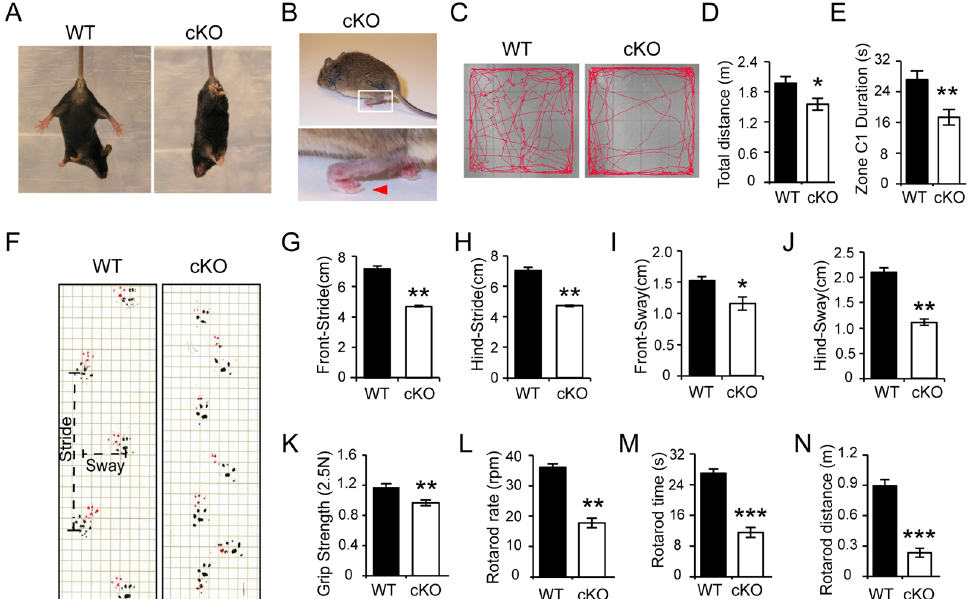
Figure 1. Thorase cKO mice exhibit behavioral deficits. ( A ) Thorase cKO mice show tremor and limb-clasping reflexes in the tail suspension test. ( B ) Thorase cKO mice at the age of 6 months walk on their tiptoes (red arrow). ( C ) Representative image showing tracks of Thorase cKO (n = 13) and WT littermate mice (n = 15) at the age of 5–6 months in open field tests. ( D , E ) Assessment of the total travel distance ( D ) and the time spent in the center (C1) ( E ) during open field tests. ( F ) Typical front (red) and hind (black) paw footprints of Thorase cKO (n = 5) and WT littermate mice (n = 4) at the age of 5–6 months. ( G – J ) Quantification of the stride length and sway distance as assessed by front stride length ( G ), hind stride length ( H ), front sway length ( I ), and hind sway length at the age of 5–6 months ( J ). ( K ) Assessment of the grip strength performance. ( L – N ) Motor coordination was assessed by the rotarod rate ( L ), the retention time on the rotarod ( M ), and the rotarod distance ( N ) for Thorase cKO (n = 13) and WT littermate mice (n = 15) at the age of 5 months. Data are presented as the mean ± SEM determined by unpaired two-tailed Student’s t-test. * p < 0.05, ** p < 0.01 and *** p < 0.001.